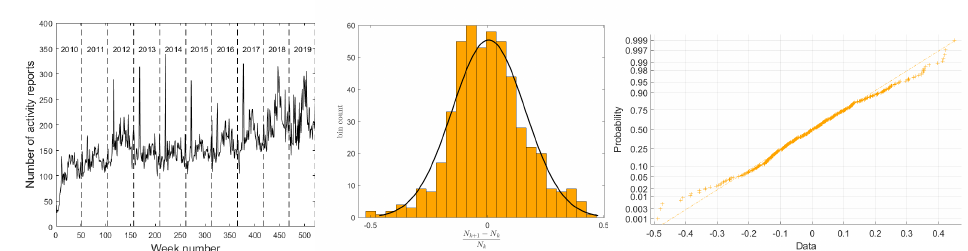
Figure 11. Analysis of the temporal increments. The left panel displays the temporal distribution of the emergency calls over the study period (2010–2019); the central panel shows the normally- distributed weekly increments; the right panel is the normal probability plot corroborating normality in the weekly increments.